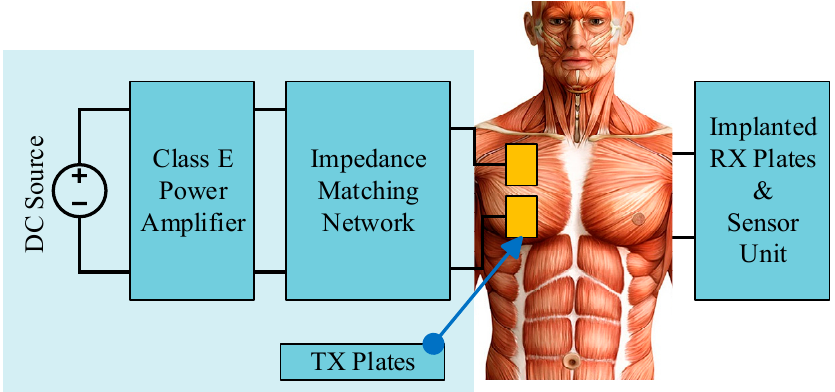
Figure 1. The diagram of capacitive coupled wireless power transfer (CCWPT) system in bio implants.